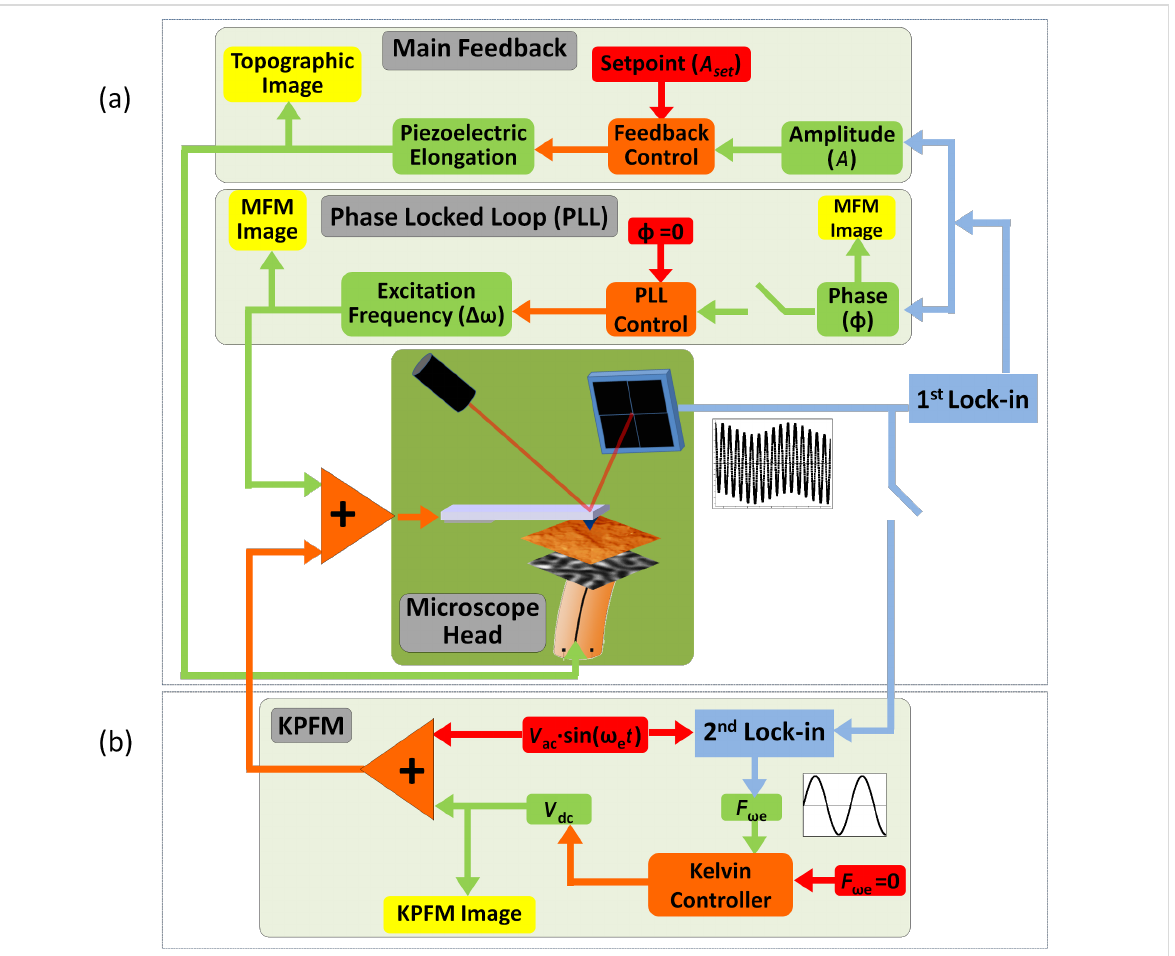
Figure 4: (a) Sketch of the different feedback loops used to perform MFM measurements with PLL system activated and (b) sketch of the MFM/KPFM combined